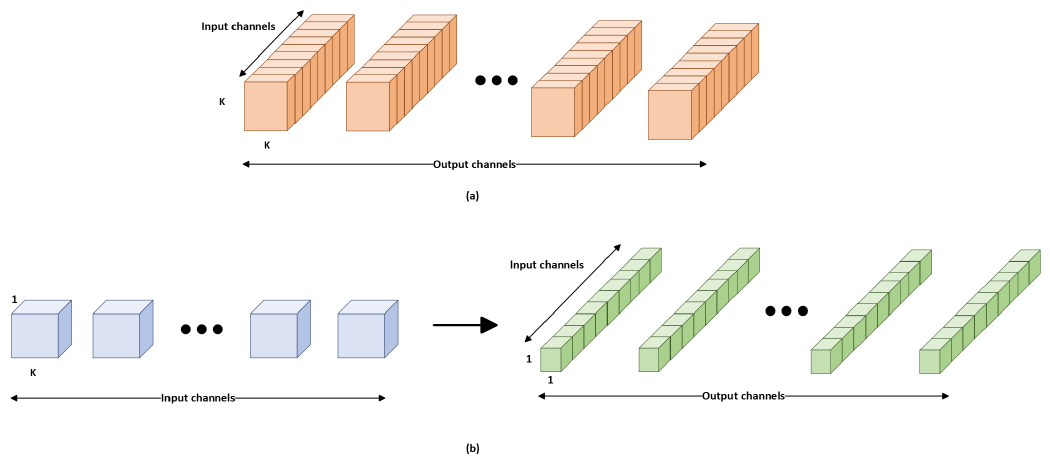
Figure 6. Comparison of depthwise separable and standard convolution layers. K refers to the kernel size. ( a ) Standard convolution filter, ( b ) Deptwise convolution followed by pointwise